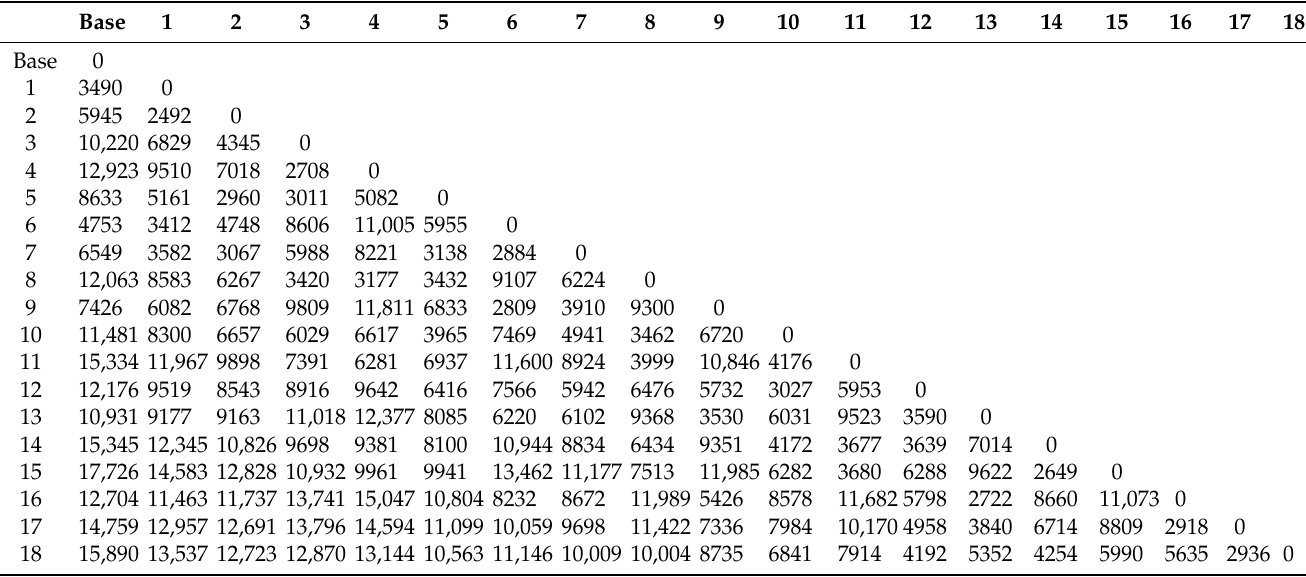
Table A1. Distance between each region or base